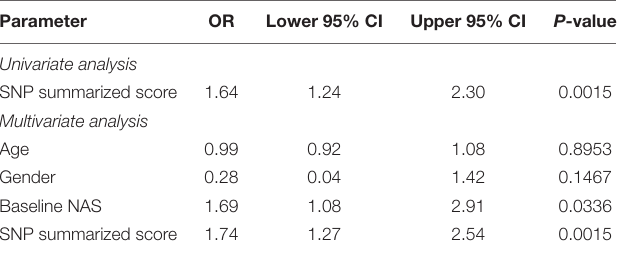
TABLE 4 | Summary of logistic regression for the primary outcome with the SNP summarized score based on PPARG rs4135275, LPL rs253, LPL rs10099160, LPL rs270, and LPL rs2197089 genotypes.